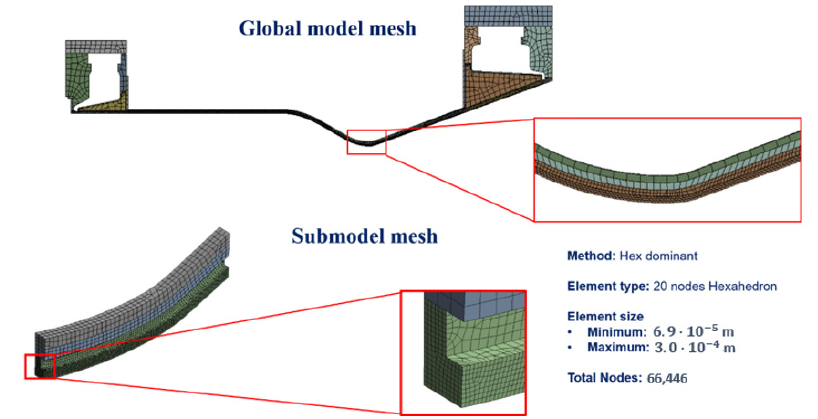
Figure 7. Adopted FEM mesh, as obtained from convergence analysis [5,6].